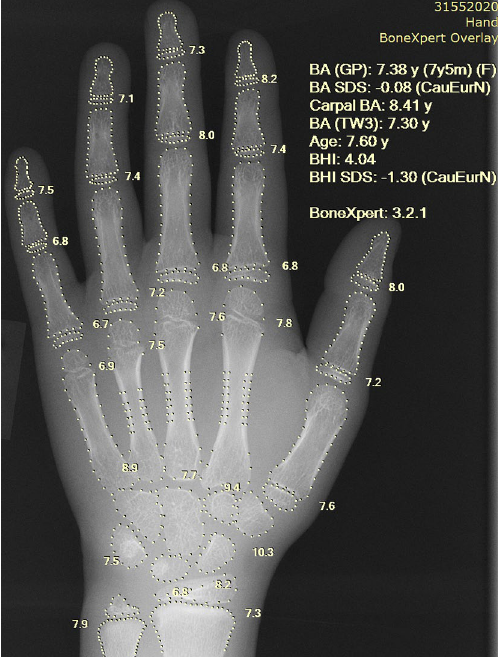
Figure 2. Posterior-anterior left-hand radiograph with bone age assessment by BoneXpert. This is the result file automatically placed in the same study in the digital archive. BA = bone age, averaged over the 21 tubular bones; BHI = Bone Health Index; SDS = standard deviation score; GP = Greulich-Pyle; TW3 = Tanner-Whitehouse Version